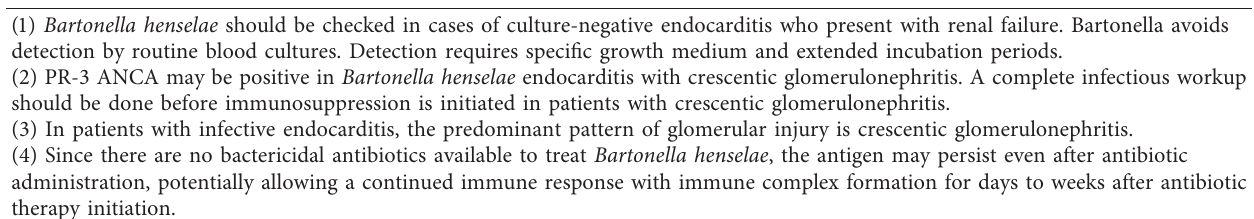
Figure 2: Echocardiogram images showing vegetations (densities) on the aortic valve with severe aortic regurgitation (arrow shows the vegetations). Table 2: Key teaching